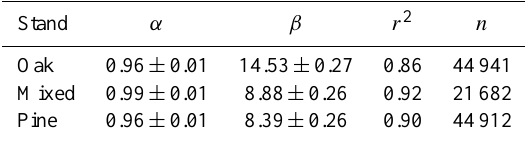
Table 2. Energy balance closure for the oak, mixed and pine stands for all half-hourly data collected from 2005 to 2009. Half- hourly flux data were fit to the equation R net – G –storage terms = α ( H + λE ) + β . Data were filtered for u ∗ values <0.2m − 2 , precipi- tation, and instrument malfunction. Values are means ± 1 Standard error, and all correlations are significant at P <0.001. Energy bal- ance closure for each stand by year is in Clark et al.